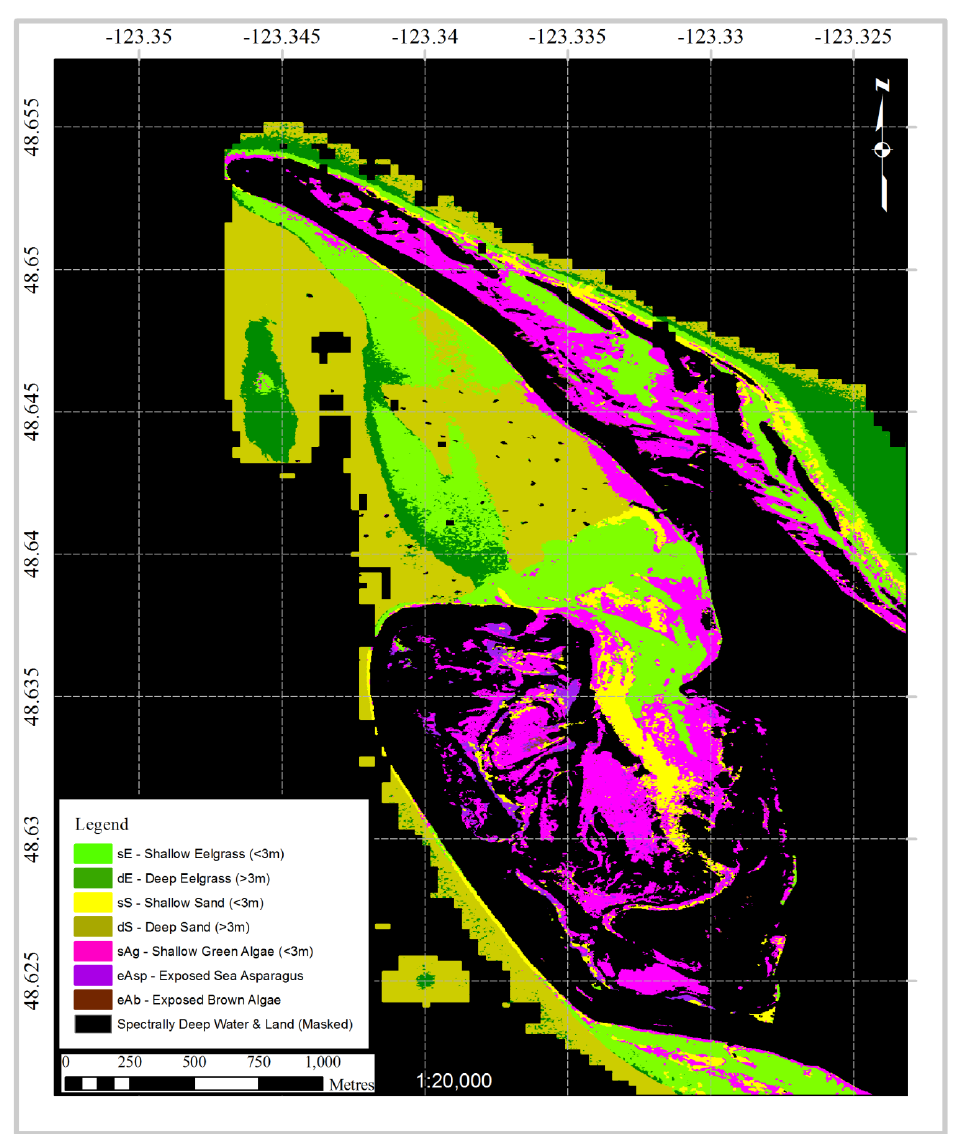
Figure 6. Most accurate eelgrass map produced in this study. Image processing steps were: atmospheric correction, glint correction, optically deep water masking, and maximum likelihood (ML) classification of the spectral variables: s500-530, R‘566, R‘580 and R‘602. Eelgrass producer/user accuracies were 85%/96% for shallow eelgrass and 98%/93% deep eelgrass. Overall accuracy was